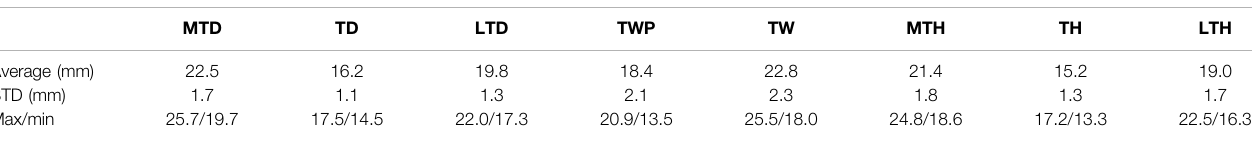
TABLE 3 | Result of all morphological